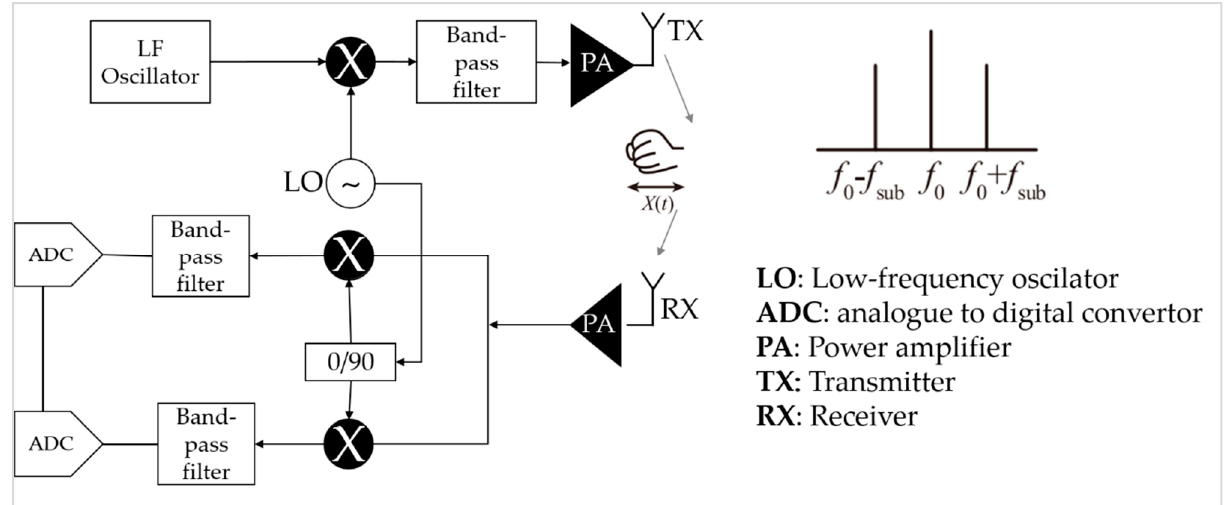
Figure 5. Block diagram of hand gesture sensing SFCW radar [40].